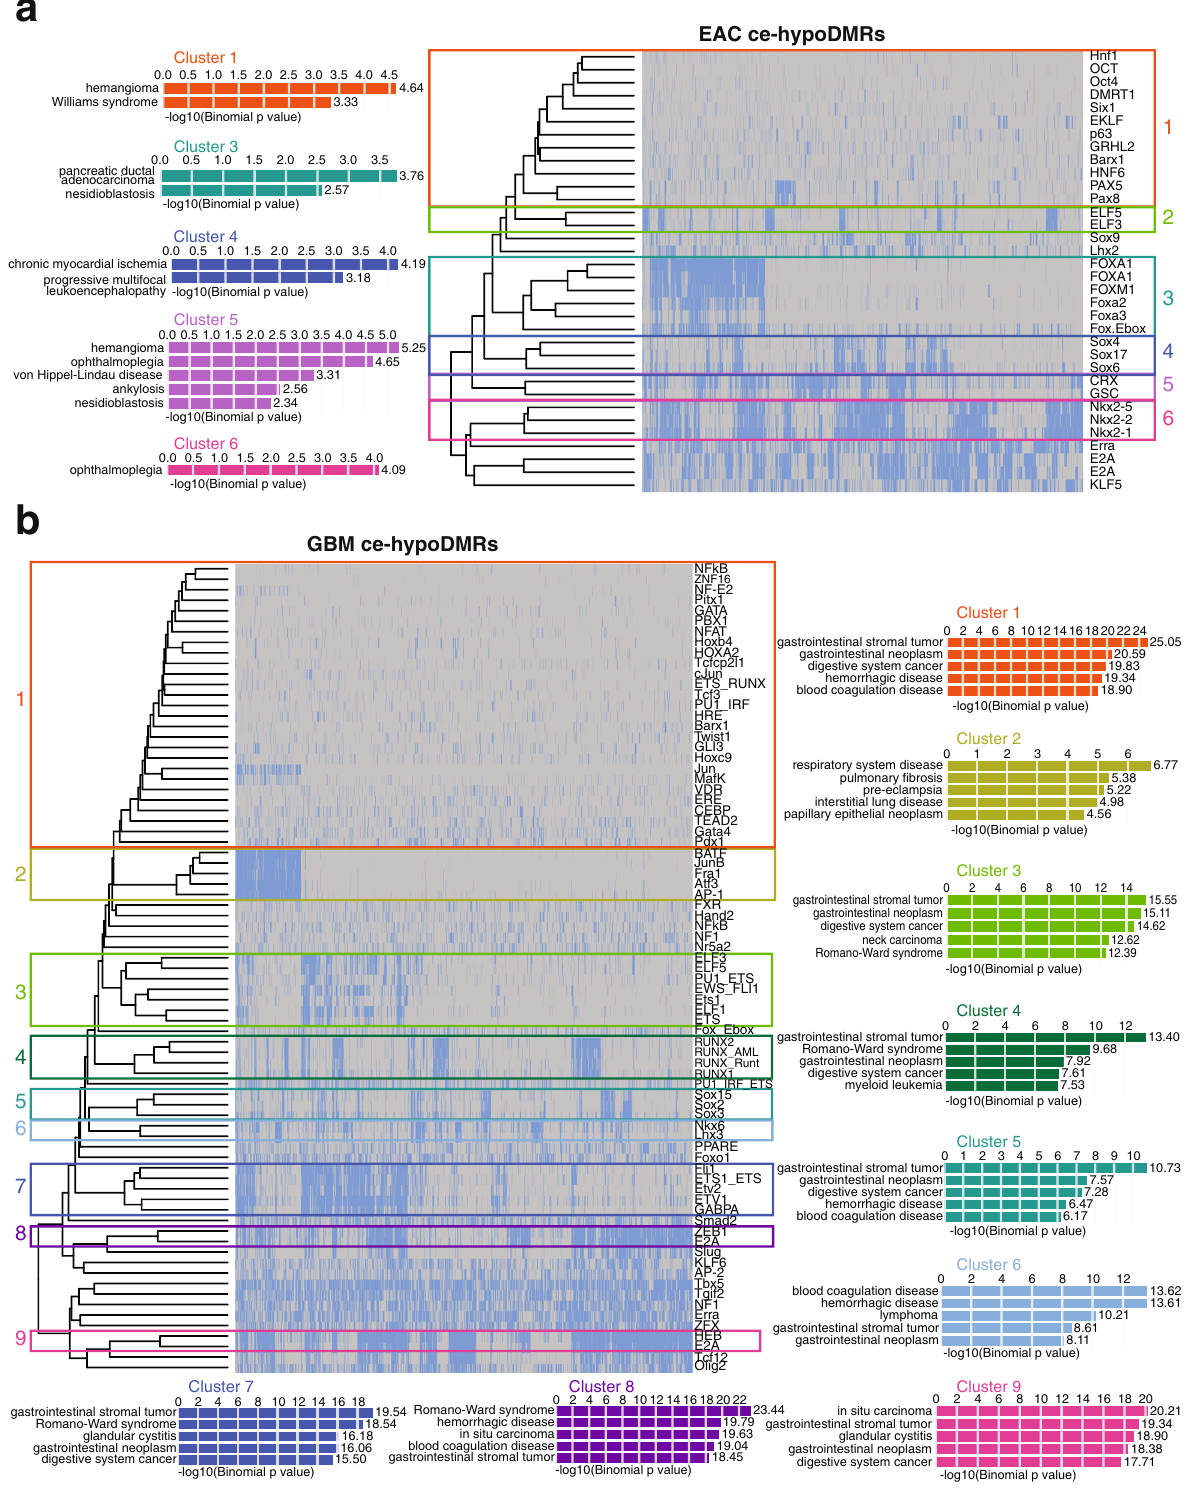
Fig. 6 Shared loss of methylation in EAC and GBM over regions encompassing cancer-related enhancers and motifs for upregulated TFs. a Heatmap indicating the presence of enriched TF-binding motifs in EAC ce-hypoDMRs and top GO disease ontology enrichment results for clusters of DMRs (blue: present; gray: absent). b Heatmap indicating the presence of enriched TF-binding motifs in GBM ce-hypoDMRs and top GO disease ontology enrichment results for clusters of DMRs (blue: present; gray: